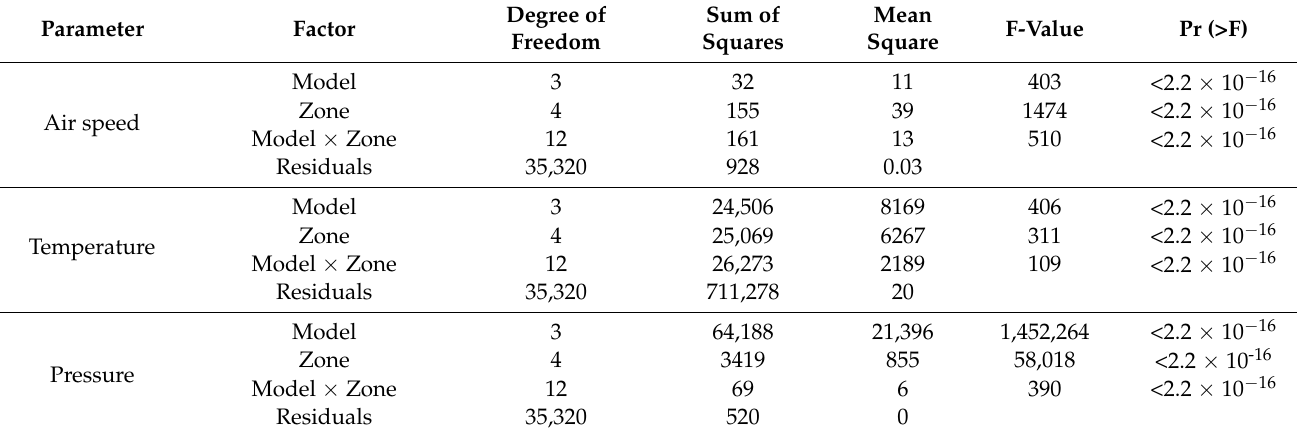
Table 2. ANOVA of environmental data from five hen-occupied zones at Plane I.